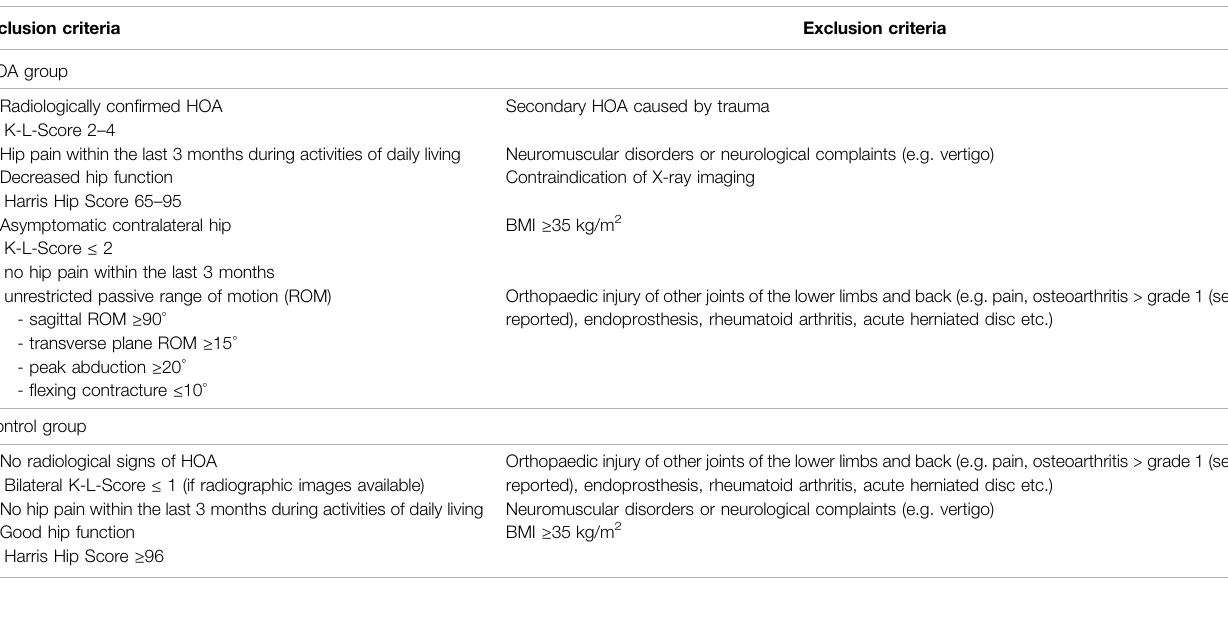
TABLE 1 | Inclusion and exclusion criteria for the HOA and control groups.